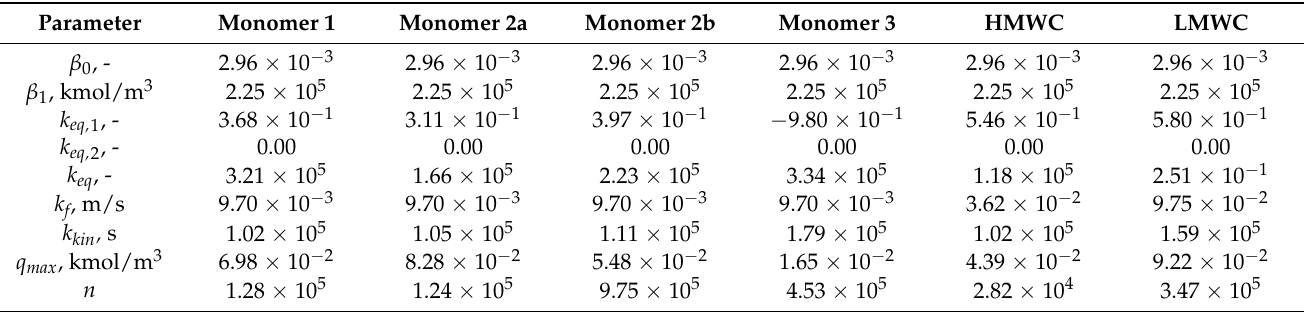
Table 10. Wang et al. model parameter values obtained with estimation on